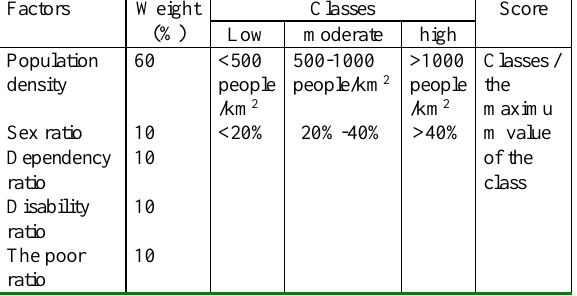
Table 3. The factors of social vulnerability (BNPB, 2012)